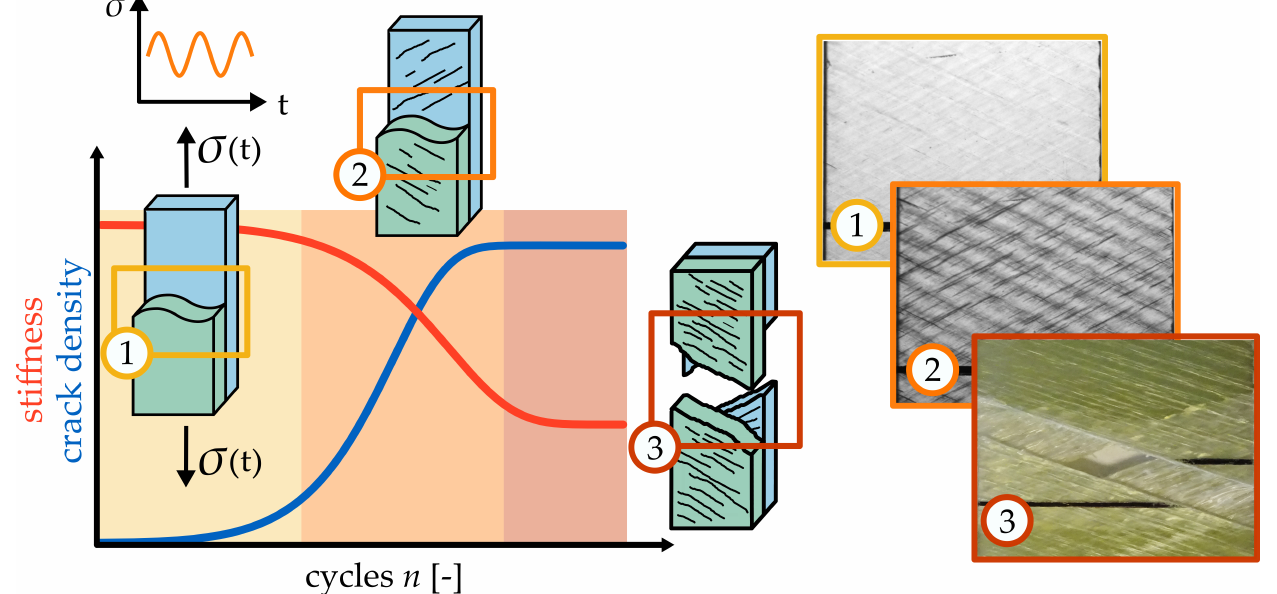
Figure 1. Evolution of off-axis cracks during fatigue tests. The stiffness stays constant as long as there are no cracks (1). After the onset of matrix cracking (2), the cracks grow in number and size and the stiffness starts to decrease due to the damage. (3) The last stage of matrix damage in composites is crack saturation and finally total failure usually due to other damage mechanisms like fiber failure and